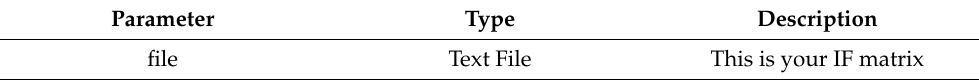
Table 1. POST http://biomlearn.uccs.edu:5001/upload, (accessed on 31 January 2023). Parameter